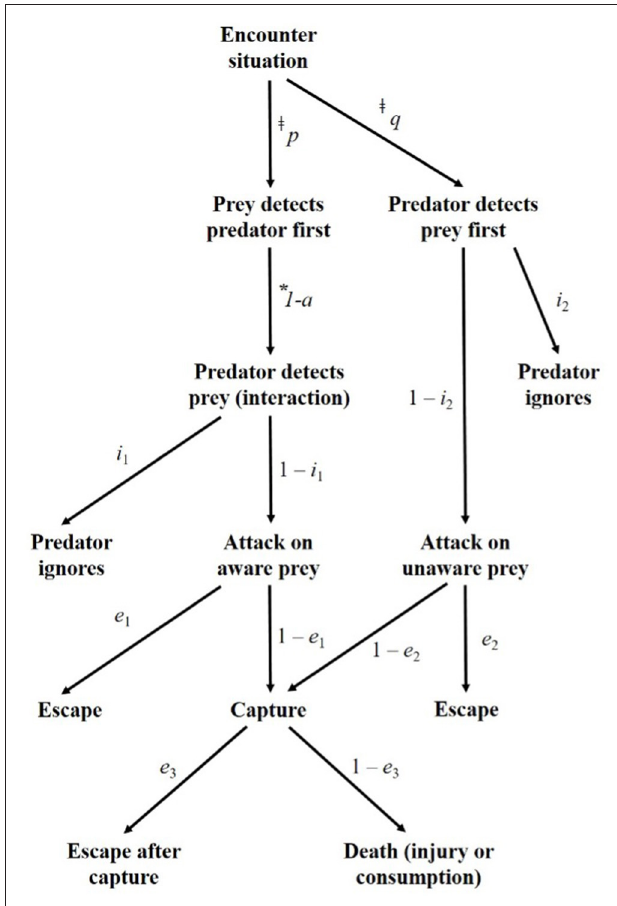
FIGURE 1 | Flow chart of the potential outcomes of carnivore-livestock encounters at the boma, adapted from Lima and Dill (1990). The text next to the arrows indicate the conditional probabilities associated with each pathway. ‡ We defined all instances in which carnivores were detected on a camera to be encounters, thus p + q = 1. *Bomas restrict livestock movement, removing the possibility of avoidance prior to detection by a carnivore. Therefore, 1 – a =